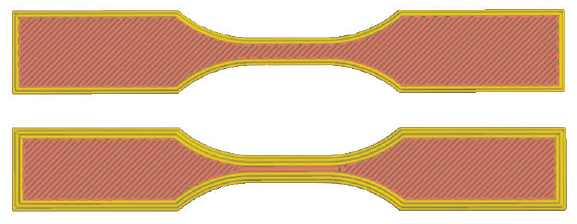
Figure 4: Specimens printed with two and three perimeter beads, respectively.